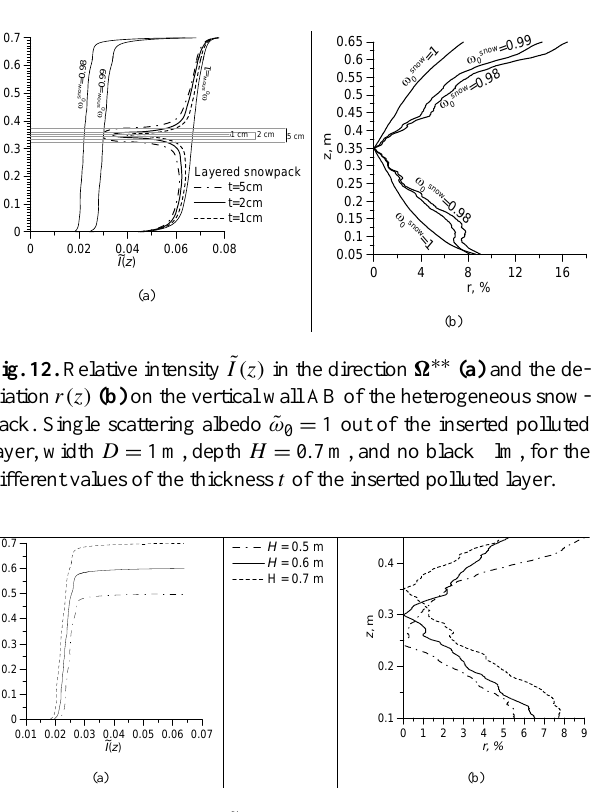
= 0 . 98, the width 0